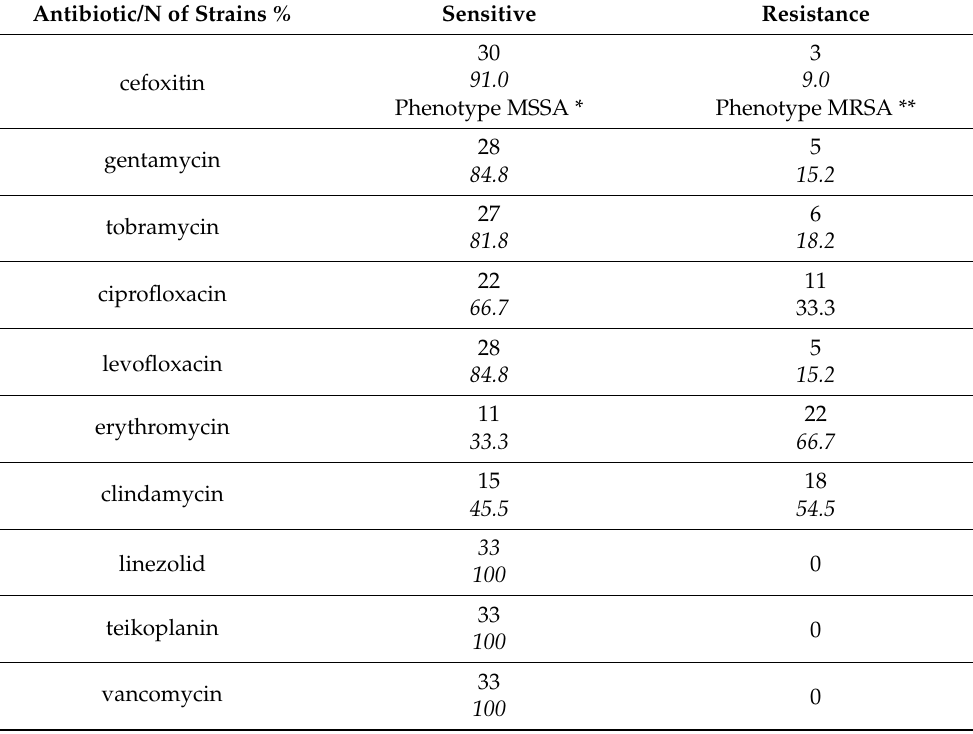
Table 1. Antibiotic resistance phenotype of the Staphylococcus aureus clinical strains. Antibiotic/N of Strains